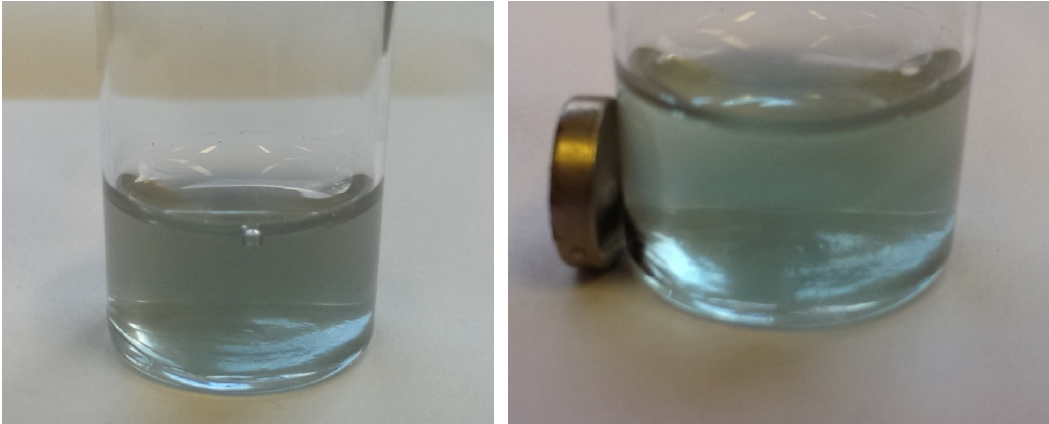
Figure 12. Images of suspended CoFe 2 O 4 @SiO 2 @TiO 2 in methylene blue solution in water ( Left ) and in the presence of a permanent magnet ( Right